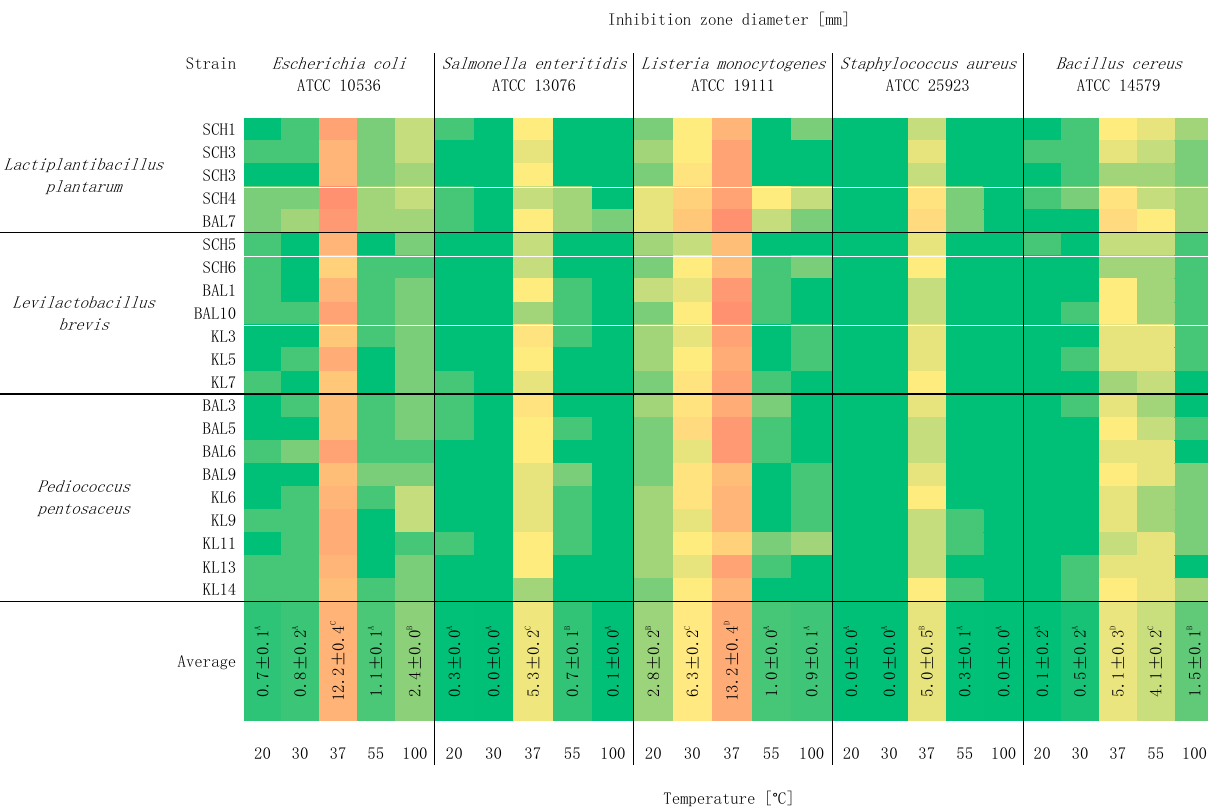
Figure 2. Heatmap about the influence of temperature on the antimicrobial activity of LAB strains and against indicator bacteria ( n = 3). Means in the same column followed by different letters (A–D) represent significant differences ( p < 0.05) for each temperature and indicator bacteria.